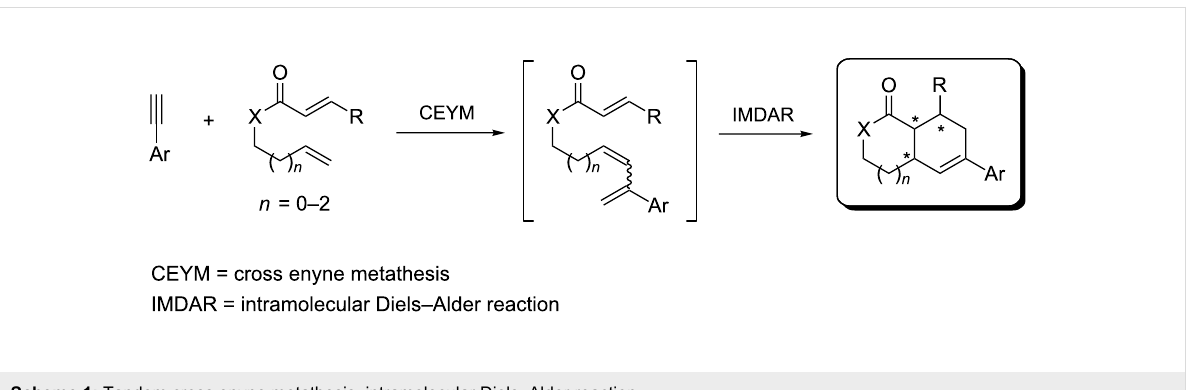
Scheme 1: Tandem cross enyne metathesis–intramolecular Diels–Alder